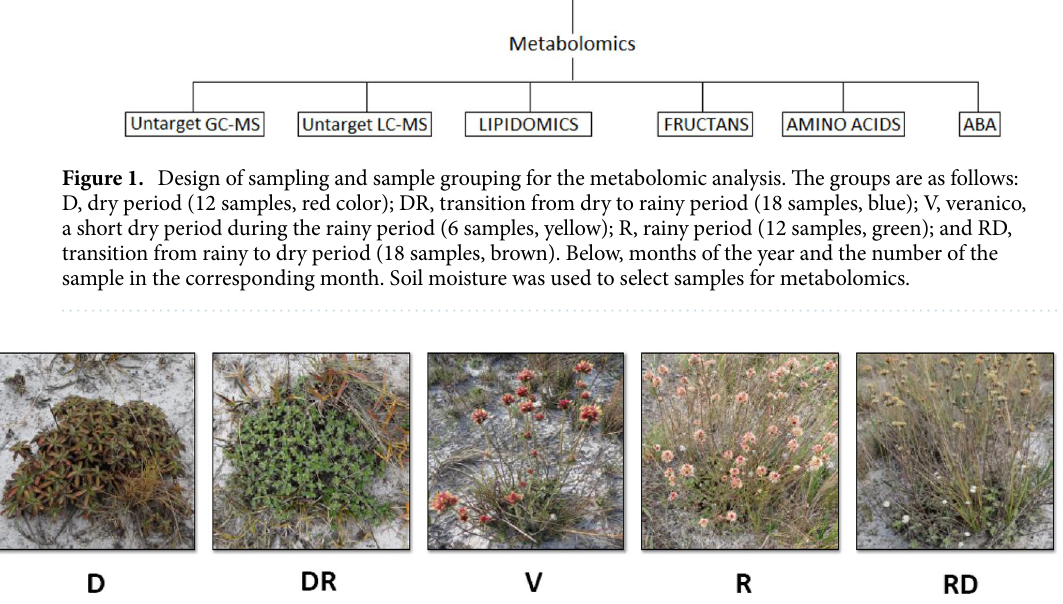
Figure 2. Phenological characterization of Gomphrena agrestis Mart. (Amaranthaceae) in a rock-field area in the dry and rainy seasons. D, dry period; RD, transition from dry to rainy period; V, veranico period; R, rainy period; and RD, transition from rainy to dry